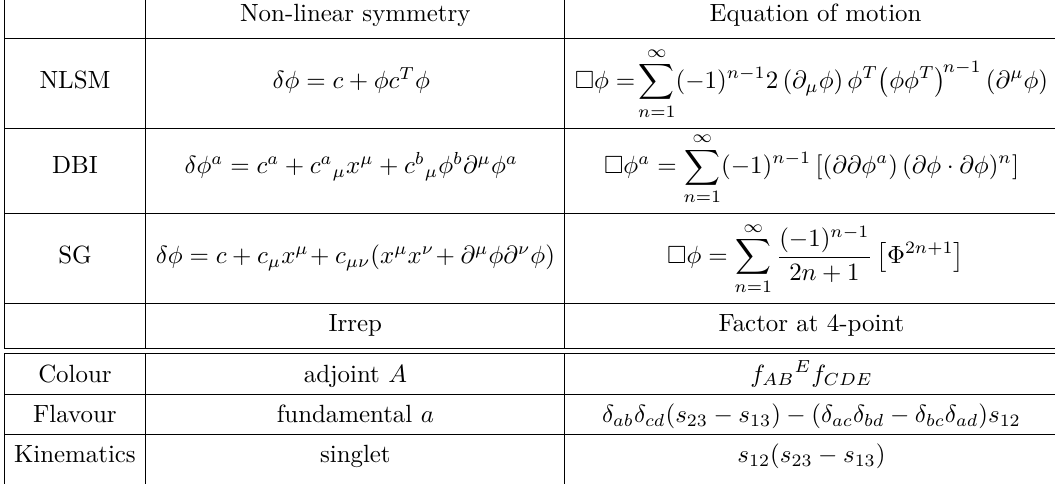
Table 1. The triplet of exceptional scalar EFTs with their non-linear symmetries and field equa- tions, and the triplet of BCJ numerators into which they can be factorised. The off-shell mapping, as outlined in section 2.2, relates different theories while the on-shell mapping (3.26) relates differ- ent